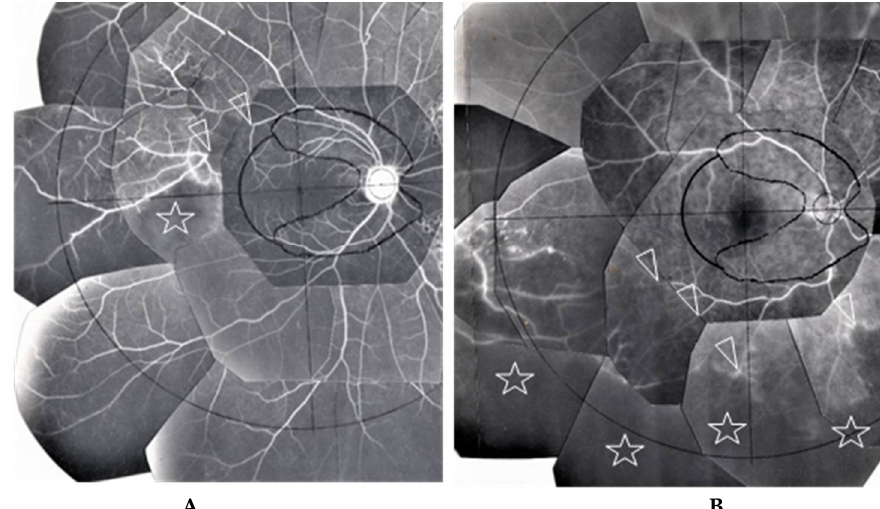
Figure 8. ( A ) Image of the right eye of Case 51, a 31-year-old male in Group III with a max IOP of 22 mmHg; ( B ) Image of the right eye of Case 6, a 65-year-old male in Group I with a max IOP of 28 mmHg. The FFA photographs were mounted on a transparent sheet with different zones. Flow in the retinal vein was abruptly stopped for 2–3 optic disc diameters (between the two arrowheads in A ). The avascular area in B (stars) was wider than that in A (star) because of 4 branch veins (arrowheads in B ) that were occluded. Retinal photocoagulation was performed in both eyes of the patients for the nonperfusion areas. Vascular occlusion (stars in A and B ) occurred mainly in Zone II and III ( A , B ), respectively. The right eye of Case 6 had undergone trabeculectomy.